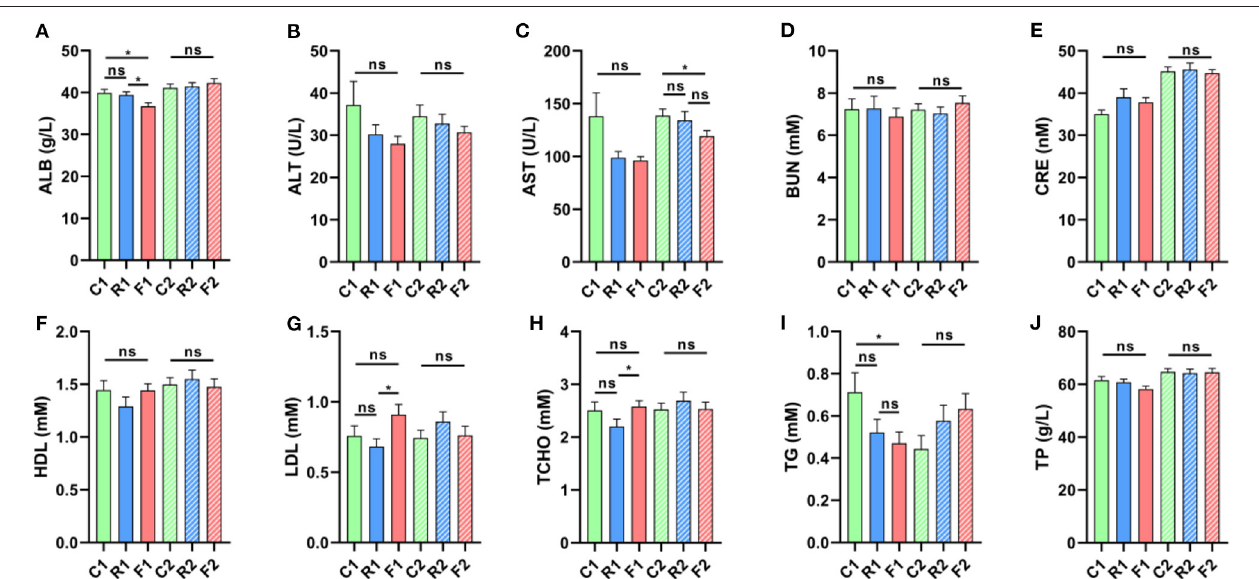
FIGURE 3 | Changes in blood biochemistry indicators in different types of diets and stages. (A) ALB had a significant decrease, F1 vs. C1 and F1 vs. R1 at stage 1, but not a significant difference at stage 2. (B) ALT did not change significantly at stage 1 and 2. (C) AST showed no significant change at stage 1, but had a significant decrease at stage 2, F2 vs. C2. (D, E, F) BUN, CRE, HDL are not a significant at stage 1 and 2, respectively. (G) LDL has a significant increase, F1 vs. R1 at stage 1, but not a significant difference at stage 2. (H) TCHO has significant increase, F1 vs. R1 at stage 1, but has not a significant difference at stage 2. (I) TG has significant decrease, F1 vs. C1 at stage 1, but not a significant difference at stage 2. (J) TP has not a significant at stages 1 and 2. *is presented p < 0.05, ns is no significant. n = 9–10. (R1 have 9 rats, C1, F1, C2, R2, and F2 have 10 rats). “ n ” means the number of samples/rats in per group.